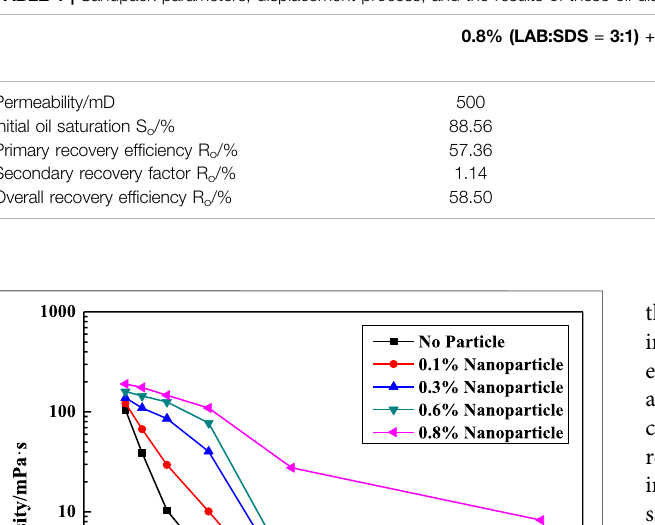
TABLE 1 | Sandpack parameters, displacement process, and the results of these oil displacement tests.